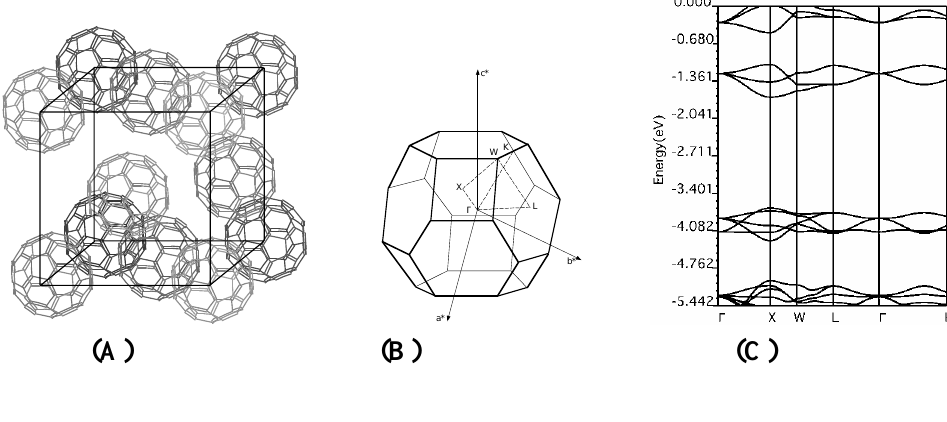
Figure S3. (A) The calculated model of f . c . c . fullerene (B) The calculated B.Z. (C) The obtained band structure. The detail information is given in the